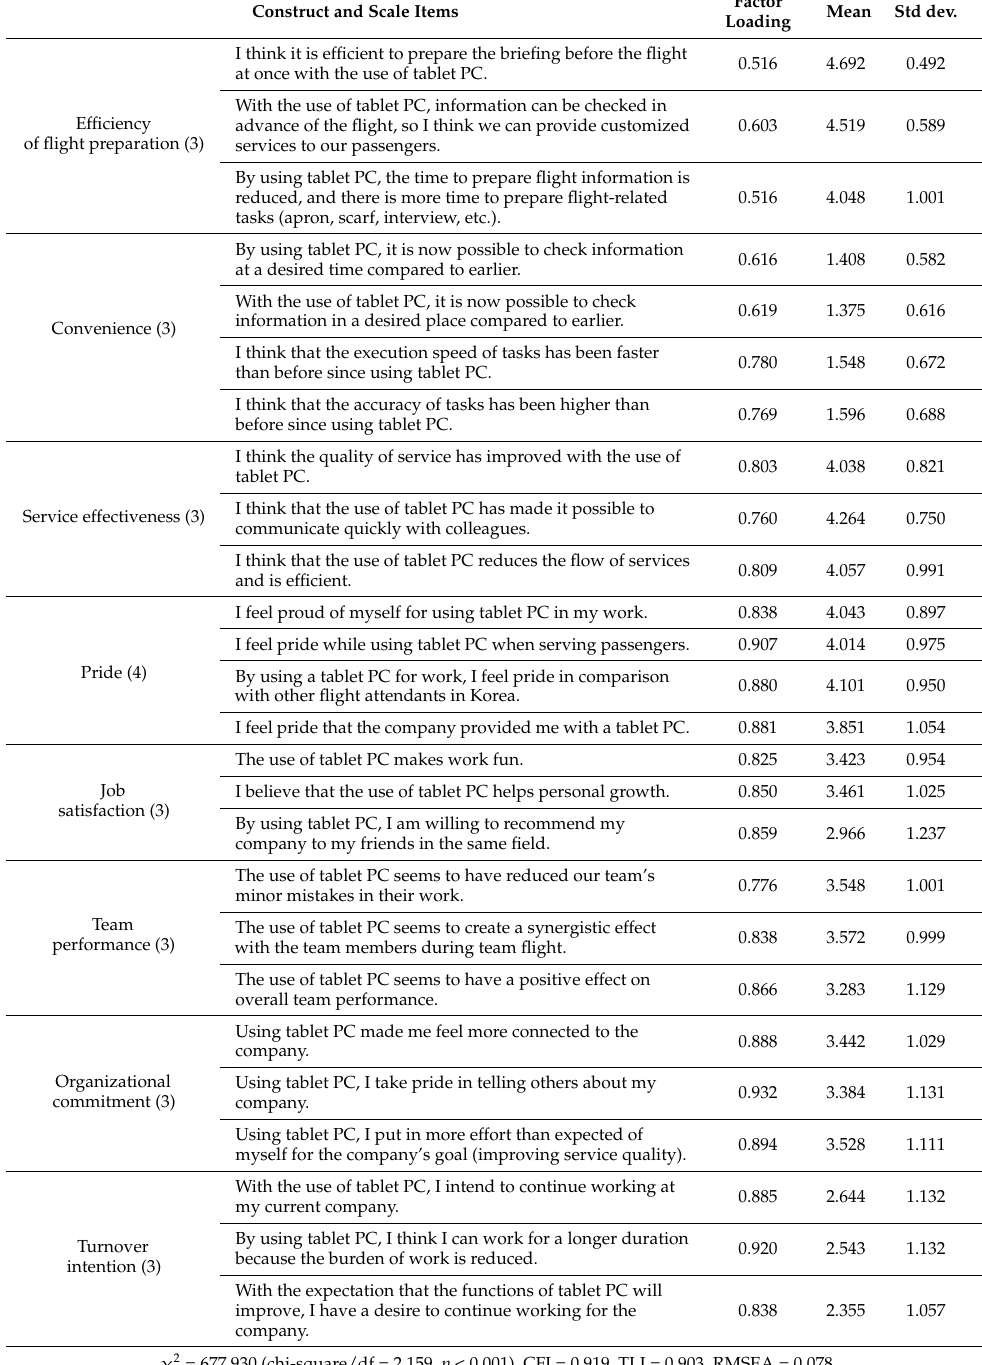
Table 2. Confirmatory Factor Analysis: Items and